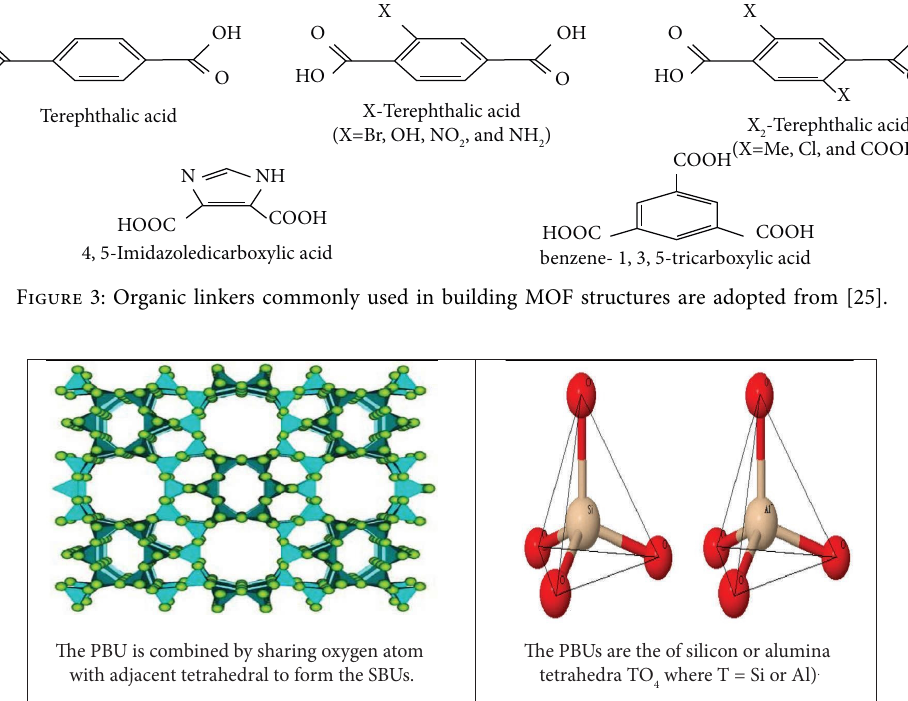
Te PBUs are the of silicon or alumina tetrahedra TO where T = Si or Al) . 4